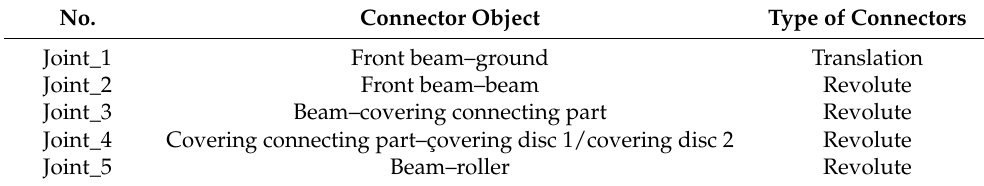
Table 2. Type of imposed constraint in the working